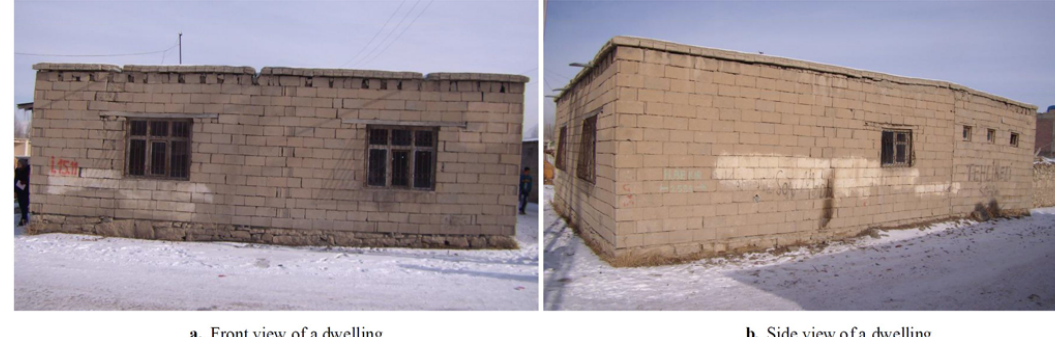
Fig. 10. Outside views of a typical unreinforced masonry